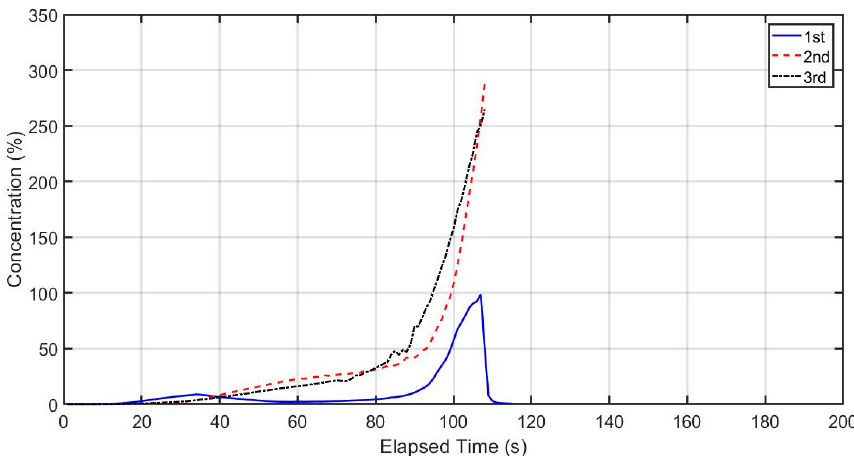
Figure 8. Results of fuel vapor concentration vs. elapsed time for the carbon canister adsorption test.